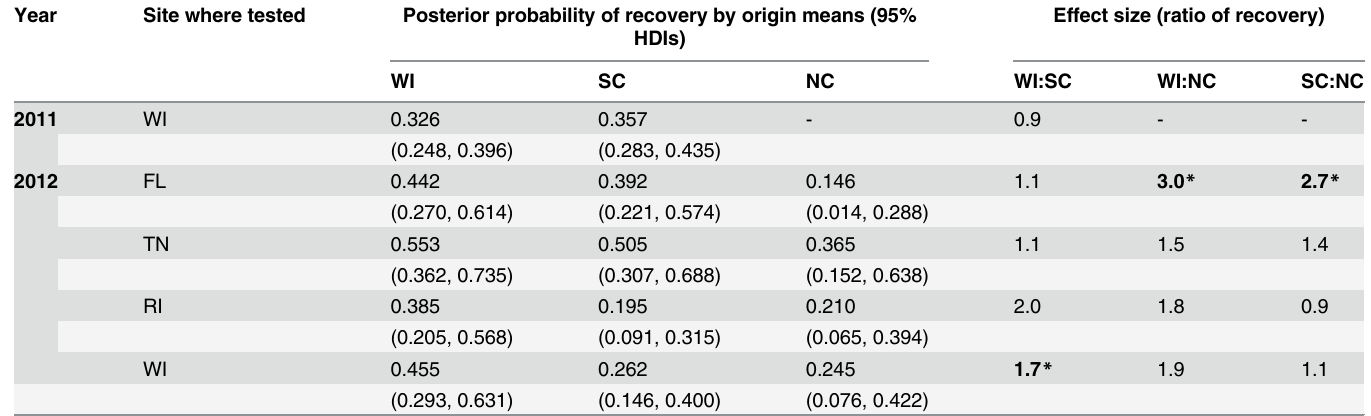
Table 2. Probability of nymph recovery as a function of nymph